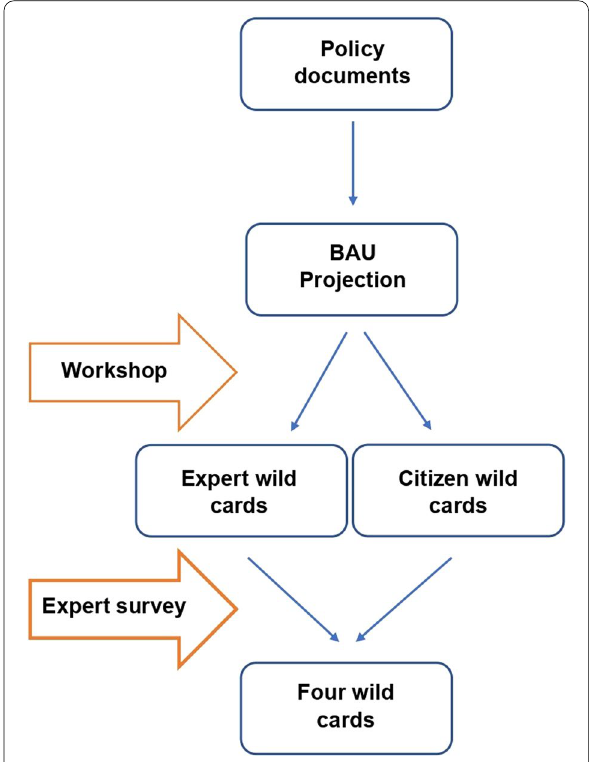
Fig. 2 Wild card development process